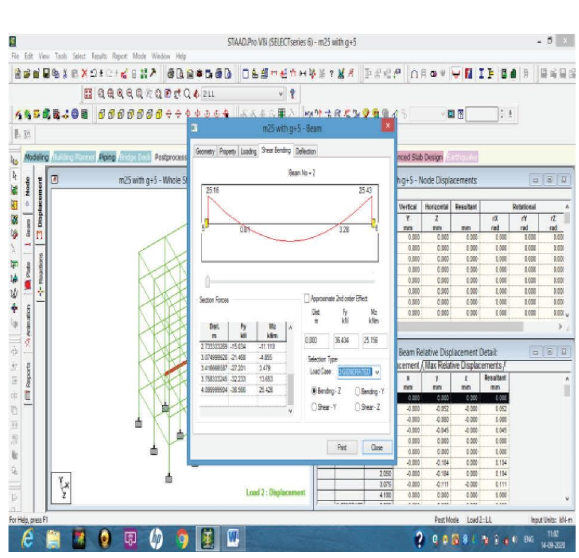
Figure 15: Defected shapes of G +5 in the X and Z